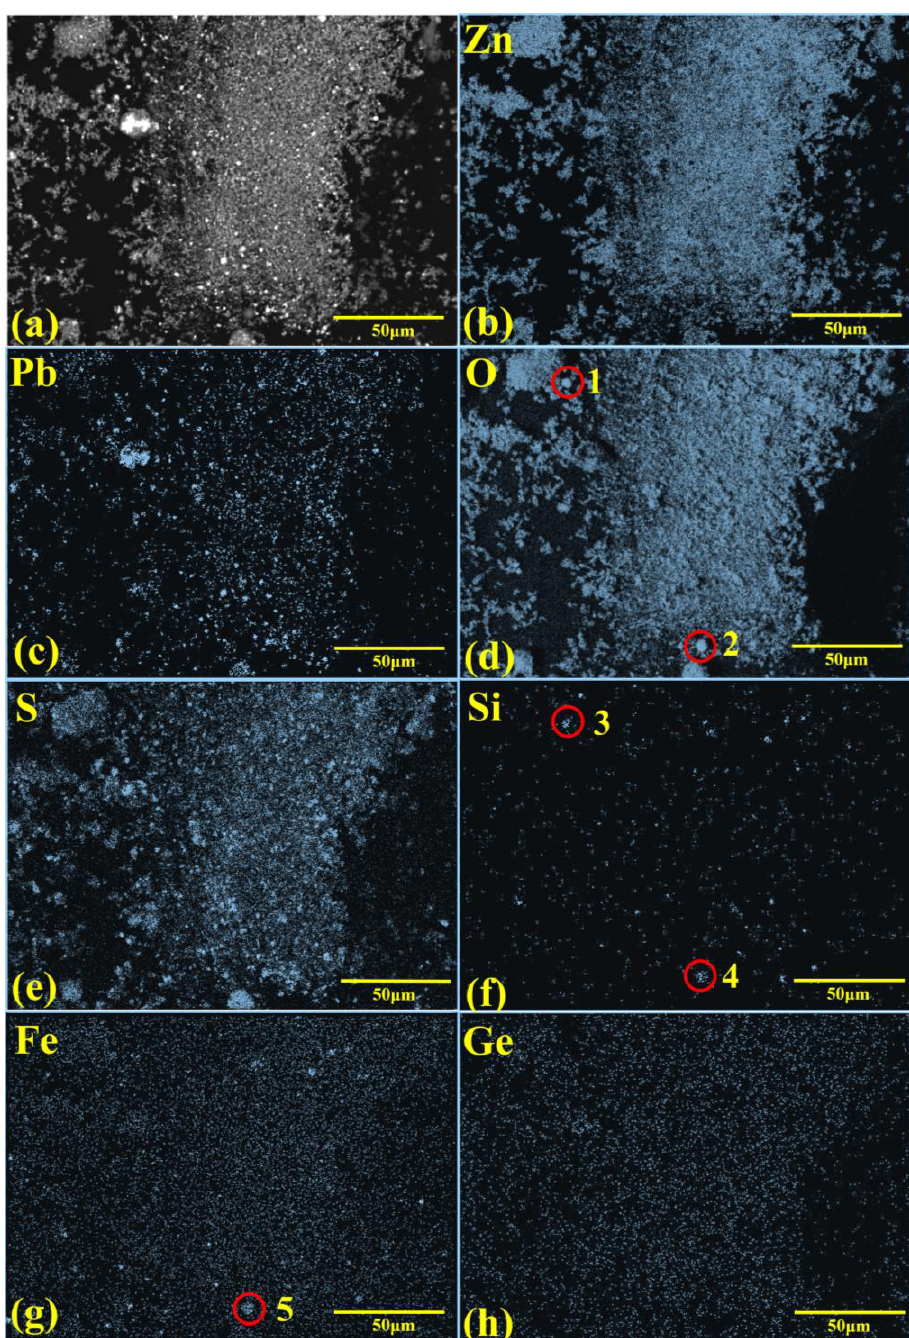
Figure 4. BSE image ( a ) and EPMA elemental images ( b – h ) of GCR.